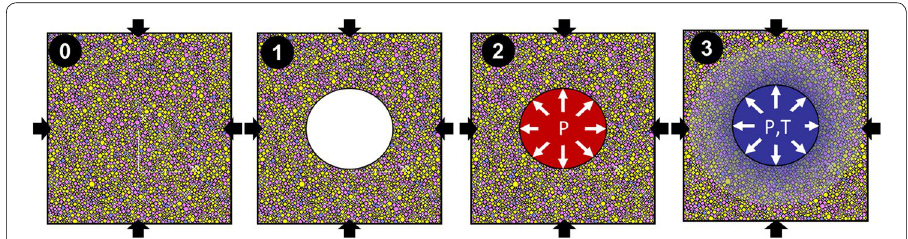
Fig. 9 Representations of the different steps of a simulation. (0) Application of the stress state on the numerical dolerite model. (1) Particles on the wellbore surface are removed to model drilling. (2) The hydraulic pressure is imposed in the wellbore. (3) The thermal loading is imposed. Black arrows symbolize the stress state. P represents the hydraulic pressure. T represents the thermal loading (cooling). The red color symbolizes the hot fluid, blue color the cold